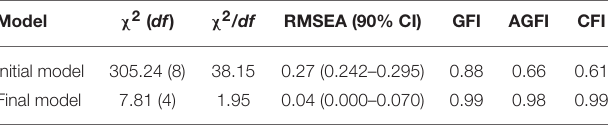
TABLE 3 | Goodness of Fit Indices From the Structural Equation Modeling